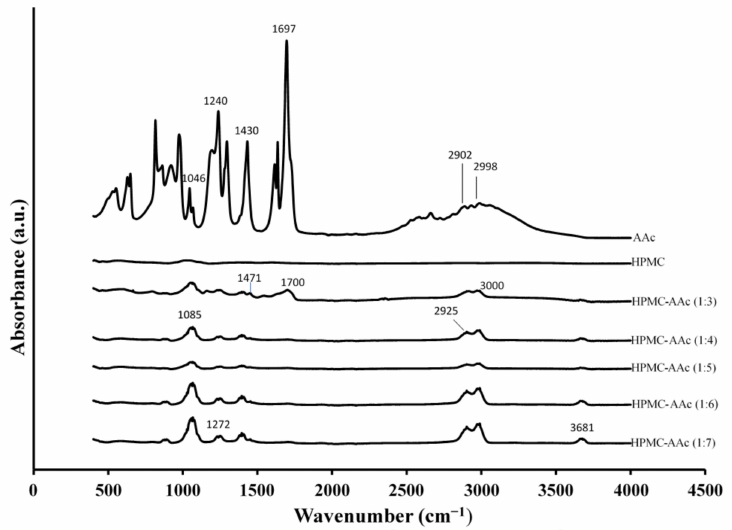
Figure 1. FTIR spectra of AAc, HPMC and HPMC:AAc systems (1:3, 1:4, 1:5, 1:6, 1:7).